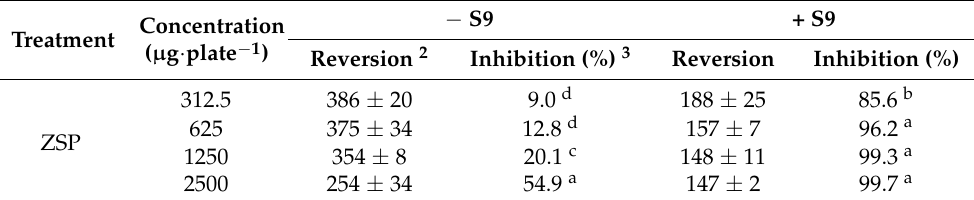
Data are expressed as the mean ± SD of triplicate experiments. ZSF: Z. schinifolium fruit extract, ZSP: Z. schinifolium pericarp extract. 1 Control: 0: Number of spontaneous His+ Revertant colonies, 1: Number of indirect